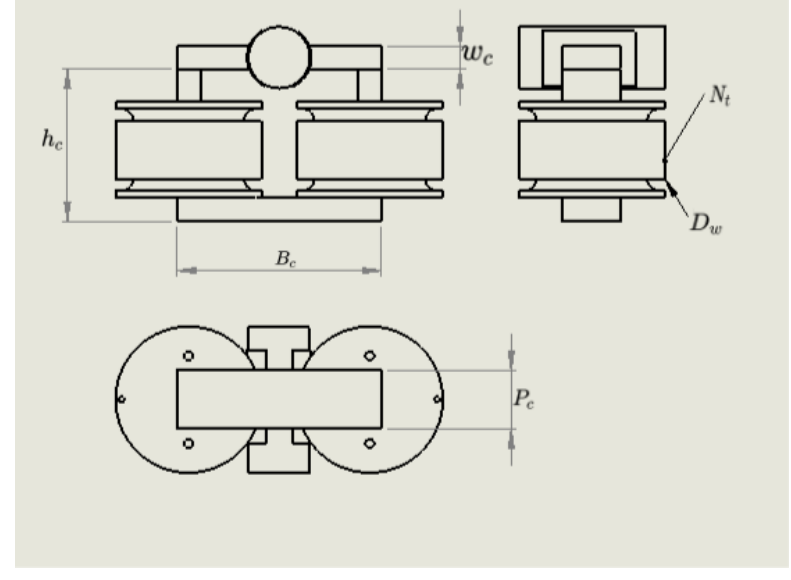
Figure 7. Geometrical parameters.